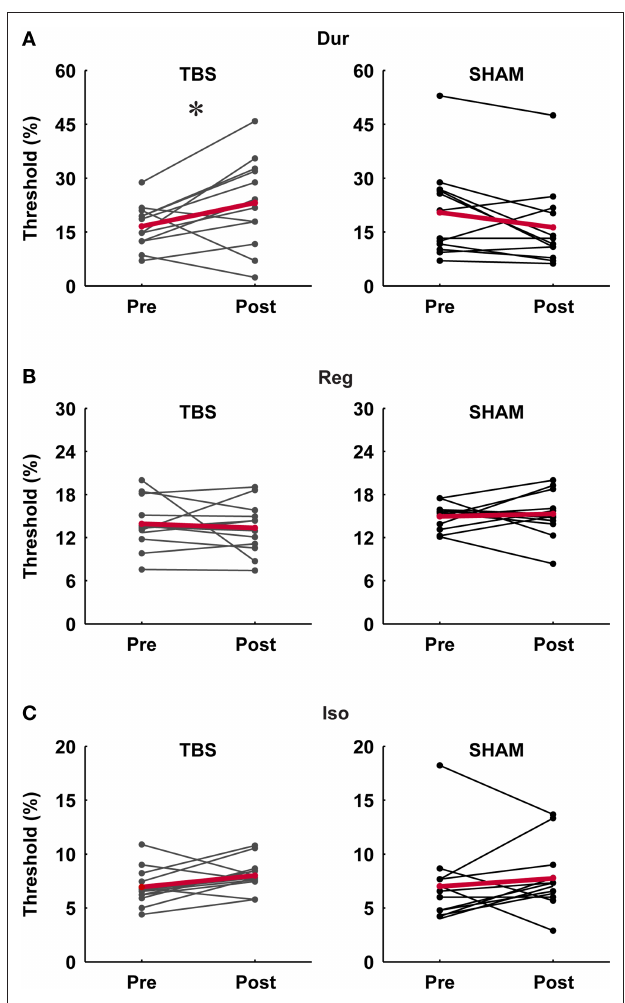
Figure 2 | individual pre- and post-stimulation thresholds for the three timing tasks in the TBS and SHAM group. (A) Single-interval duration discrimination (Dur), (B) regularity detection (Reg), (C) isochrony-deviation detection (Iso). There was a significant effect of TBS on duration discrimination thresholds ( p < 0.05; paired t -test) (A) but no significant effect on those for the other tasks; SHAM stimulation had no significant effect on any of the